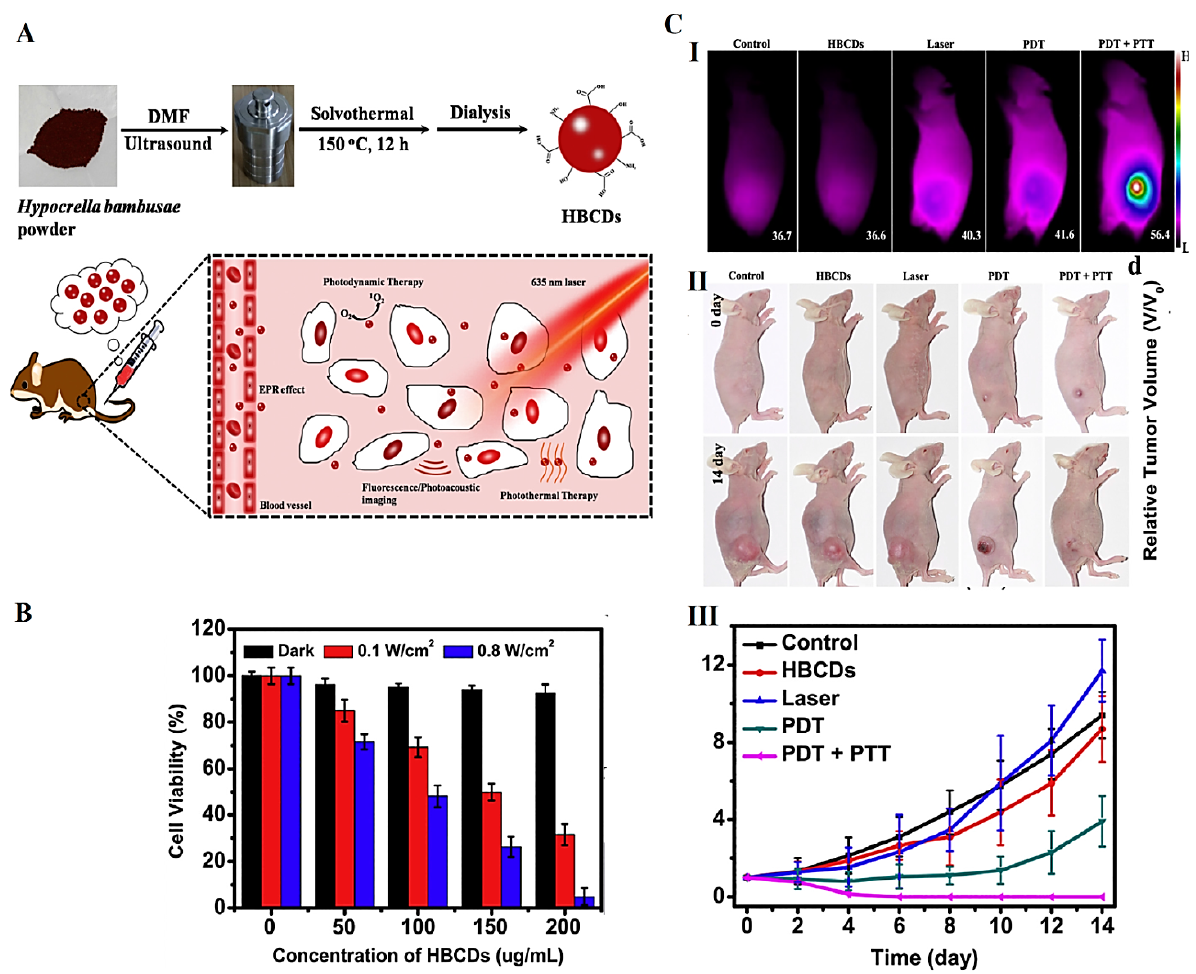
Figure 4. ( A ) The preparative process of CDs derived from H. bambusae (HBCDs) with bimodal fluorescence/photoacoustic imaging and synergistic photodynamic/photothermal therapy potentials. ( B ) Cell viability analyses of HeLa cells treated with biowaste ‐ derived CDs. ( C ) Infrared thermal images of mice post various treatments ( I ). Photographs of mice post different treatments ( II ). The growth curves of tumors during various treatments ( III ). DMF: dimethylformamide. Reproduced with permission from Ref [54] . Copyright 2018 Elsevier.